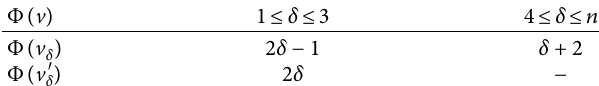
Figure 1: A classical mean labeling of 2 ST Table 1: Vertex labeling of Φ ( v ).